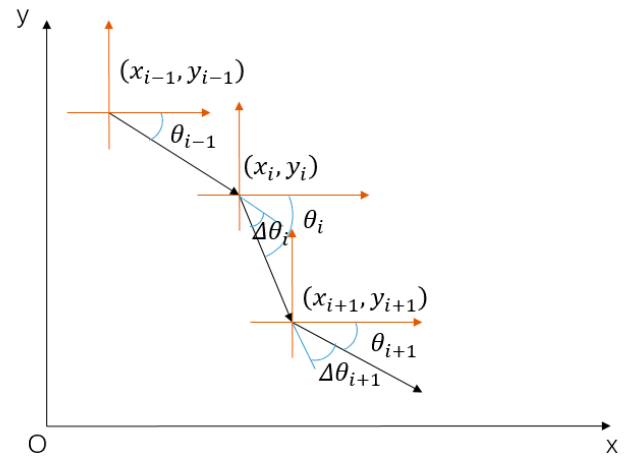
Figure 7. Steering angle diagram.